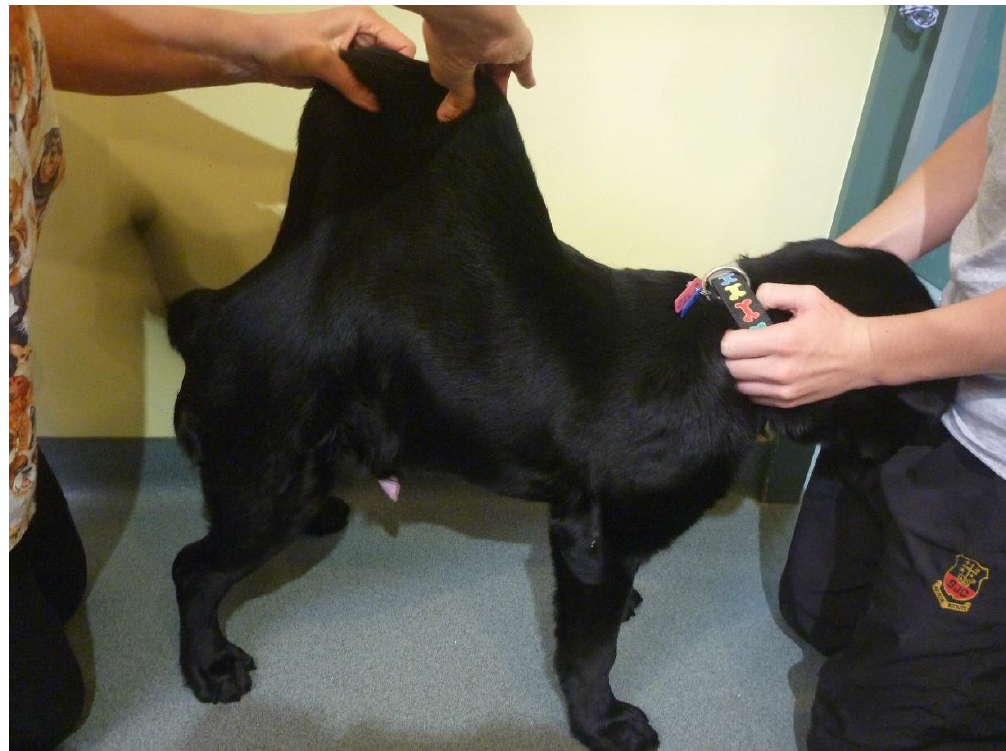
Figure 2. Case 1, Skin hyperextensibility over the dorsum.